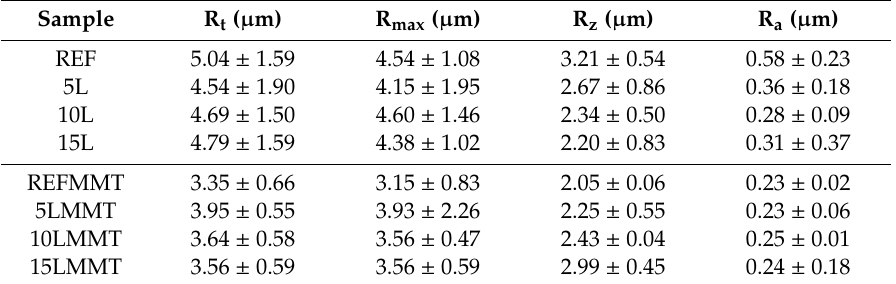
Table 6. Roughness parameters for the materials coated utilizing the LbL method, where: R a —the arithmetical mean roughness; R max —the maximum peak height; R t —the linear distance between the top of peak and base of the valley; and R z —the height of roughness presented on a scale of ten points.